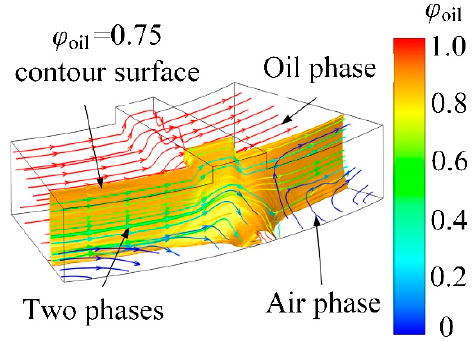
Figure 5. Streamline figure of fluid flow with the φ oil = 0.75 contour surface shown.